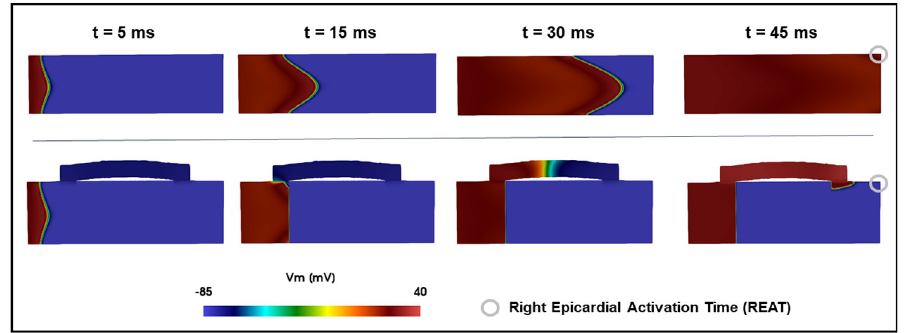
Fig 6. Sample activation pattern. Upper row: propagation in a healthy slab. Lower row: propagation in a sample simulation of the fixed setup, showing the delay in REAT activation.